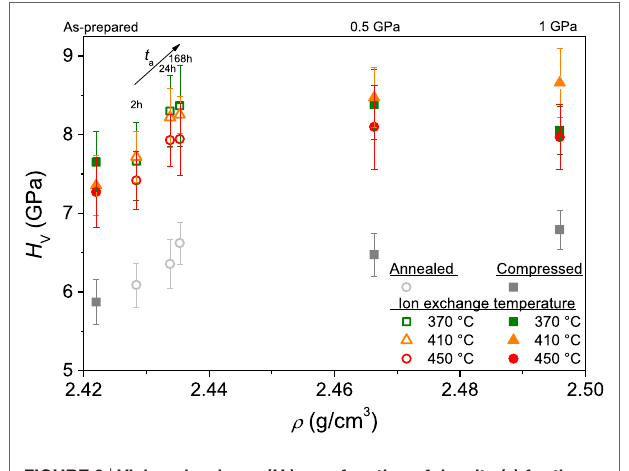
FigUre 10 | The increase in Vickers hardness due to the ion exchange treatment ( Δ H V ) as a function of the generated compressive stress (cs) for glasses annealed (open symbols) or compressed (filled symbols) and then ion exchanged at three different temperatures (370, 410, and 450°c) . The dashed line is a guide for the